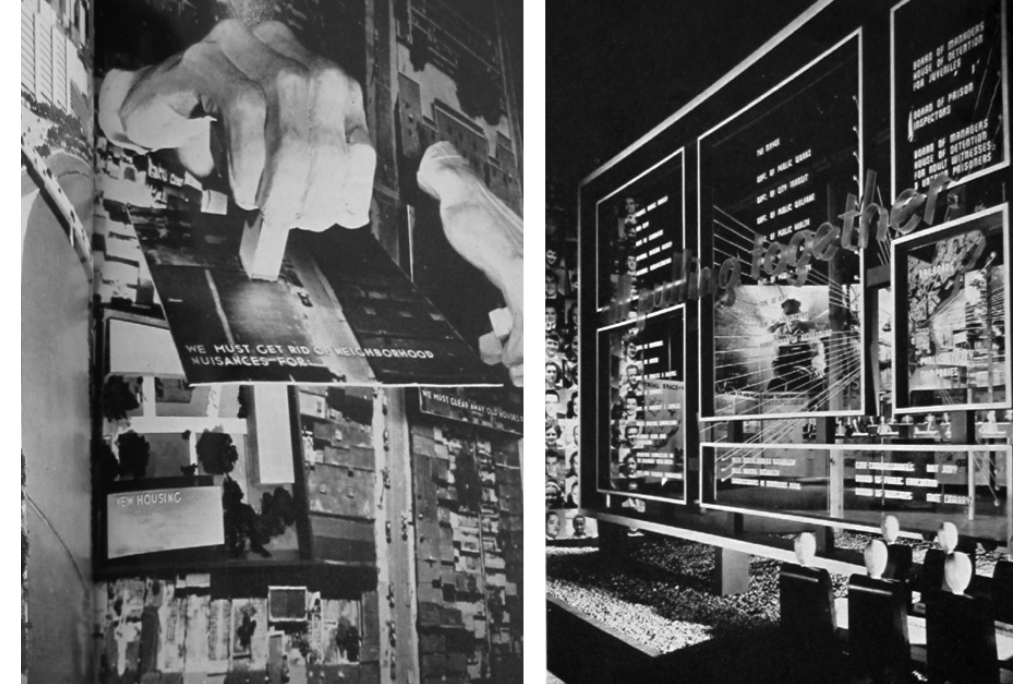
Figure 12. Better Philadelphia Exhibition, 1947. Source: Stonorov and Bacon (1946). Urban Planning, 2022, Volume 7, Issue 1, Pages